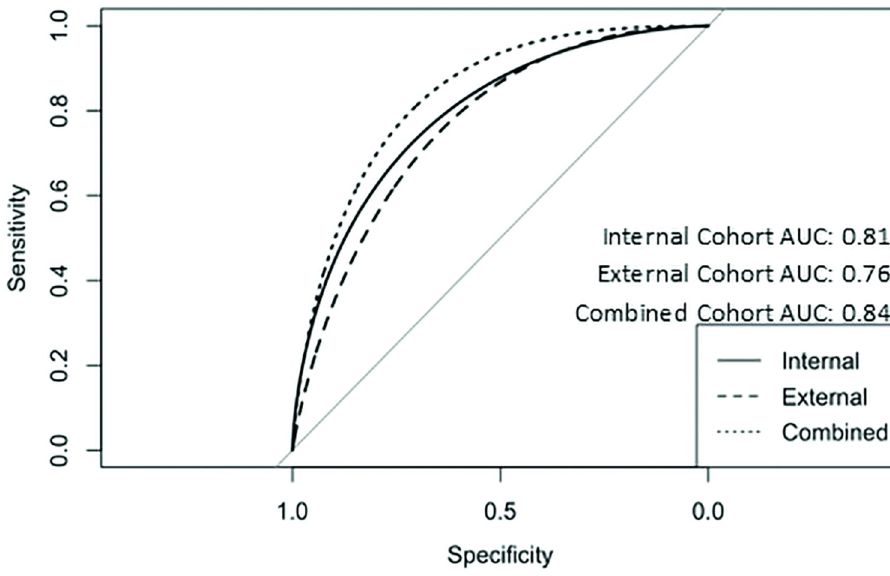
Fig 2. Smoothed ROC curves and AUC ROC for predictive model applied to internal, external and combined cohorts. Abbreviations: AUC = area under the curve, ROC = receiver operating